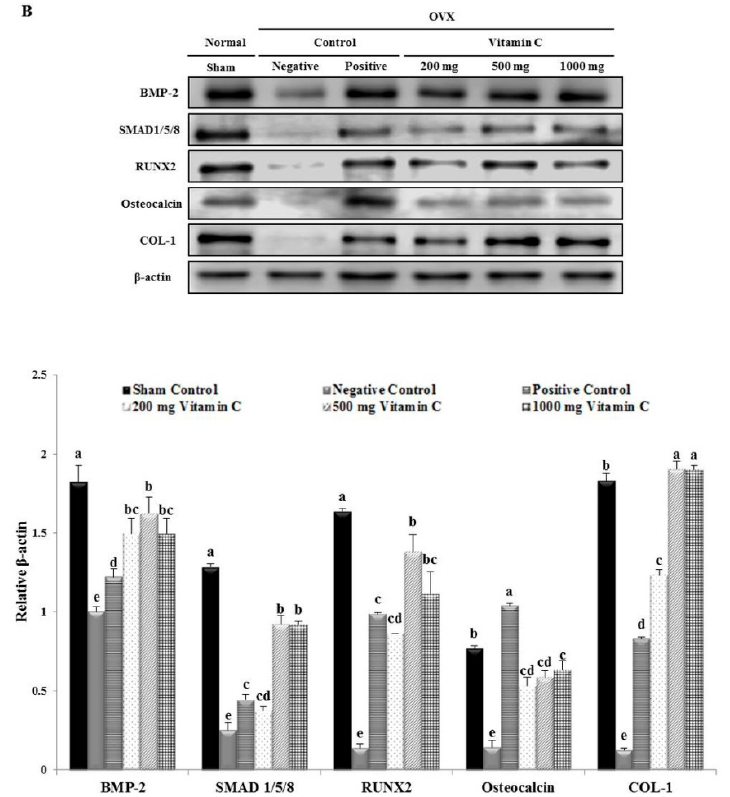
Figure 5. Effect of vitamin C on osteoblast-related gene and protein expression in the tibias of OVX rats. ( A ) Reverse transcriptase-polymerase chain reaction (RT-PCR) products of osteoblastogenesis-related genes. Quantitative assay of mRNA expression levels of BMP-2 , RUNX2 , osteocalcin and COL-1 in vitamin C-treated OVX rats. ( B ) Western blot image of osteoblastogenesis-related proteins and quantitative assay of BMP-2, SMAD 1/5/8, RUNX2, osteocalcin, and COL-1 protein expression in vitamin C-treated rat tibias. Expression was quantified using ImageJ software relative to that of glyceraldehyde 3-phosphate dehydrogenase (GAPDH) and β -actin. Values represent the mean ± standard deviation. Values with different letters were significantly different according to Duncan’s multiple range test ( P < 0.05).